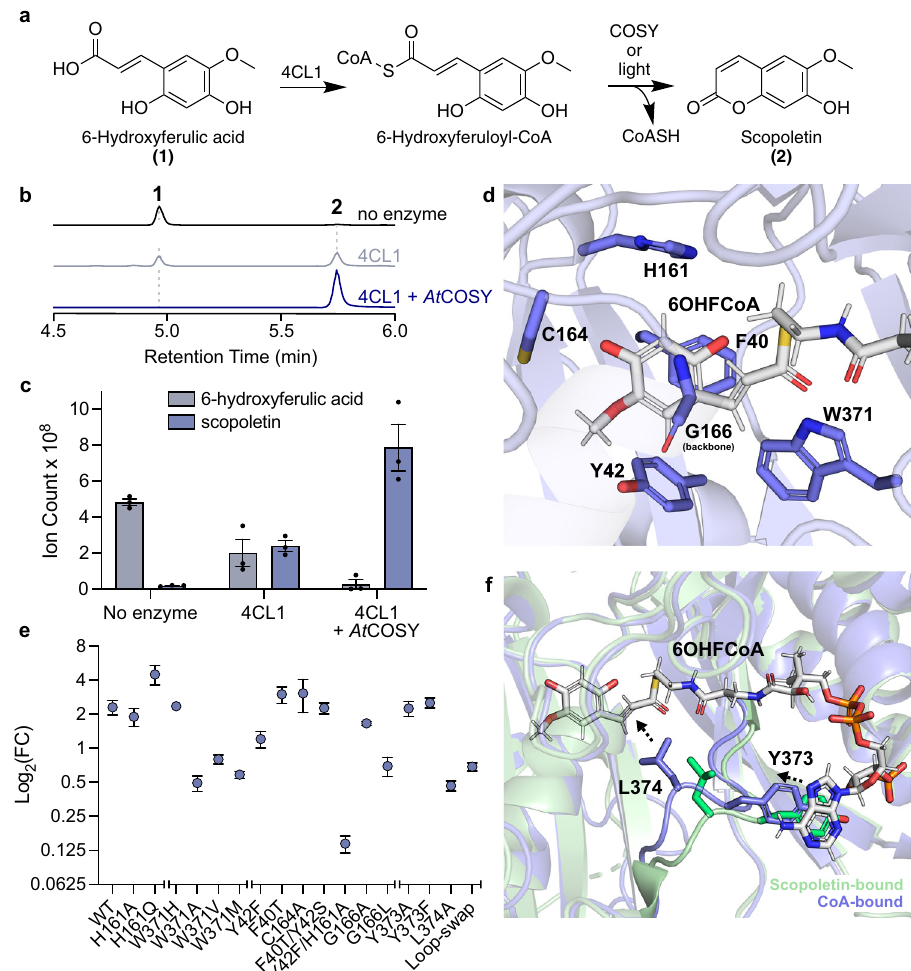
Fig. 2 | In vitro coupled biochemical assay that examines the coumarin syn- thase activity of At COSY. a Reaction schematic of the conversion of 6-hydroxyferulic acid (6OHFA) to scopoletin using 4-coumarate-CoA ligase 1 from A. thaliana ( At 4CL1) and coumarin synthase ( At COSY). b Combined LC-MS extracted ion chromatograms (XICs) of 165.05556 m / z and 209.04549 m / z ; 1 , and 191.03443 m / z ; 2 . As scopoletin production is spontaneous, assay carried out in absenceof At COSYservesasthebaselinecontrolforthecoumarinsynthaseactivity measurement. 4CL1+ At COSY sample shows complete conversion of 6OHFA into scopoletin. c Total ion count of 6OHFA and scopoletin from LC-MS for the enzy- maticassays intriplicates. Data are presented as mean values+/ − standarderrorof the mean. Relevant quantitative data underlying this fi gureisprovided asa Source data fi le. d Reconstructed pose of trans − 6OHFCoA in the active site of the CoA- bound At COSY structure. Phe40, Tyr42, His161, Cys 164, Trp371, and backbone atoms of Gly166 are highlighted as they make close contact with the